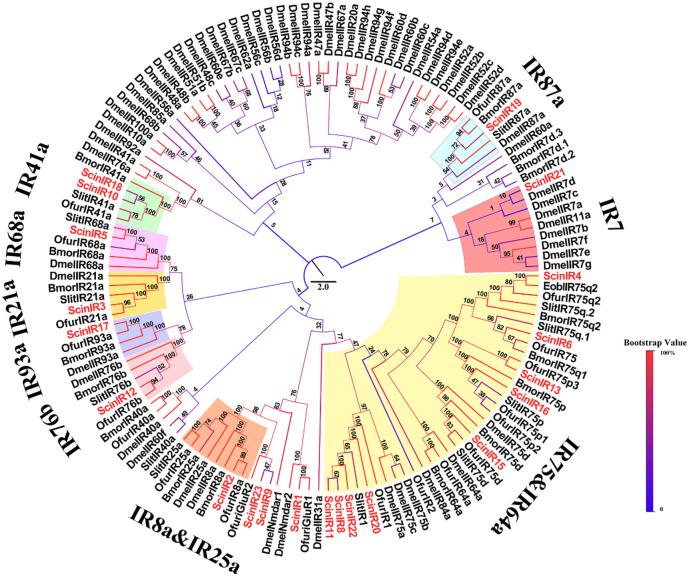
Phylogenetic tree of IR proteins in Semiothisa cinerearia, Ectropis obliqua, Spodoptera litura, Ostrinia furnacalis, Bombyx mori and Drosophila melanogaster.The sequences used in this analysis are listed in S9 Table.